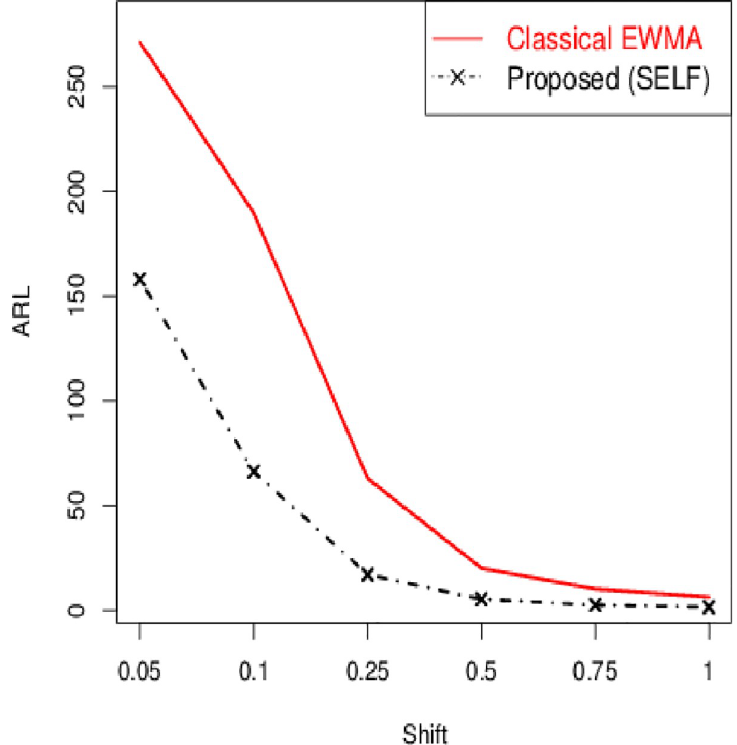
Fig 5. ARL comparison of proposed Bayesian Modified-EWMA chart (under SELF) with existing classical EWMA chart for n = 5 and λ = 0.05.